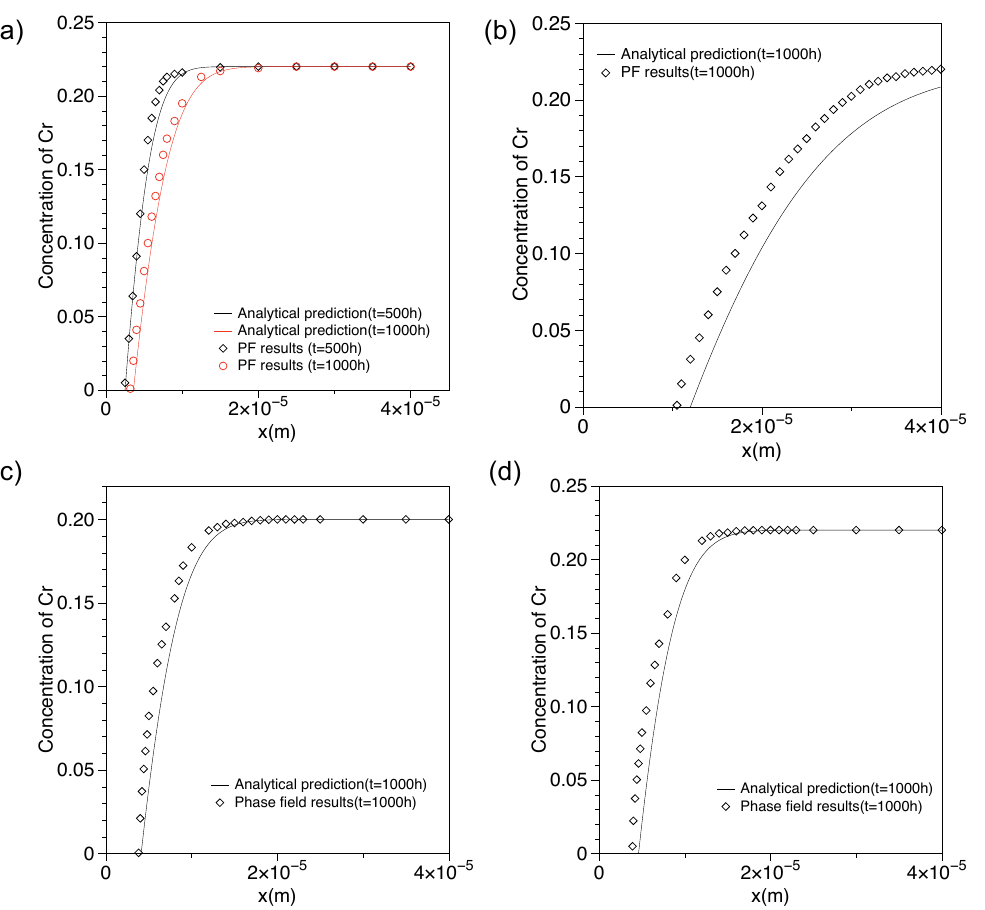
= 0.05, N 0 = 0.22, O Cr = 0.05, N 0 = 0.20, ( d ) T = 1073 K, O Cr